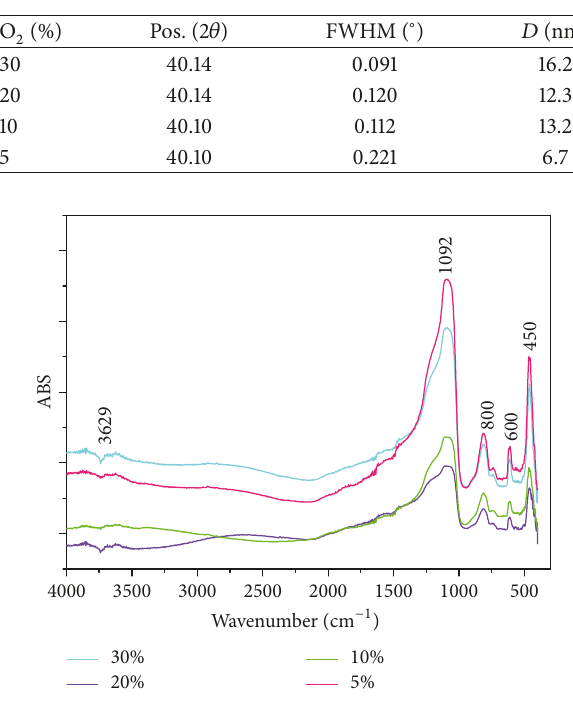
Figure 2: FTIR spectra of TiO 2 under different flow rate of oxygen.